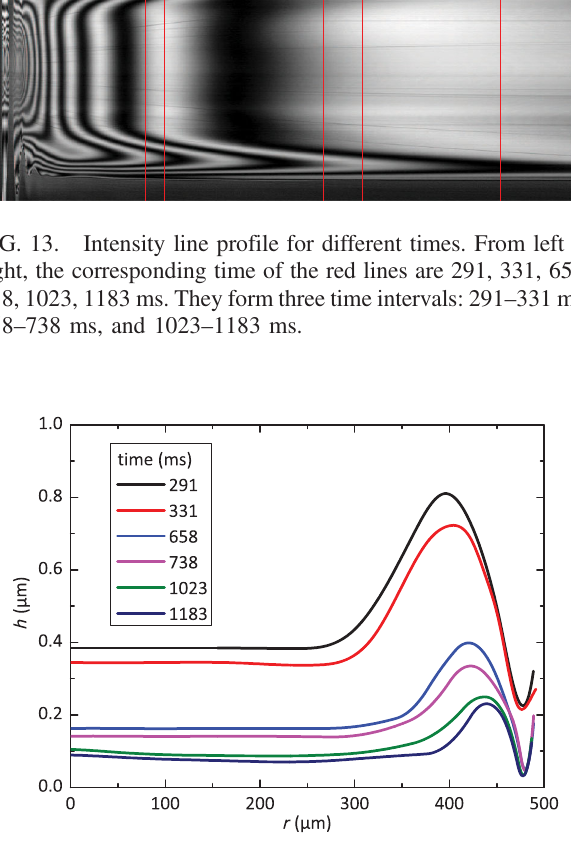
FIG. 14. Air film profiles at six different times indicated by the red lines in Fig. 13. Note that they form three time intervals and the length of each interval is different.